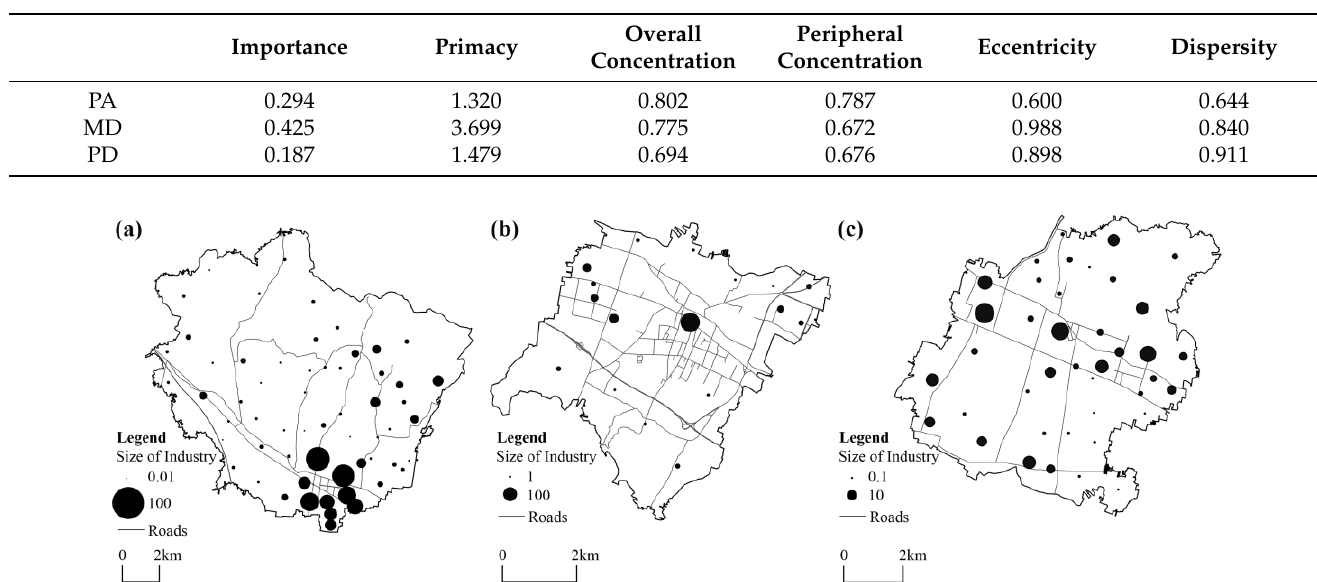
Figure 8. Typical spatial patterns of within-township industrial distribution: ( a ) Yangliu with a PA pattern; ( b ) Xinwen with a MD pattern; ( c ) Zhaizhen with a PD